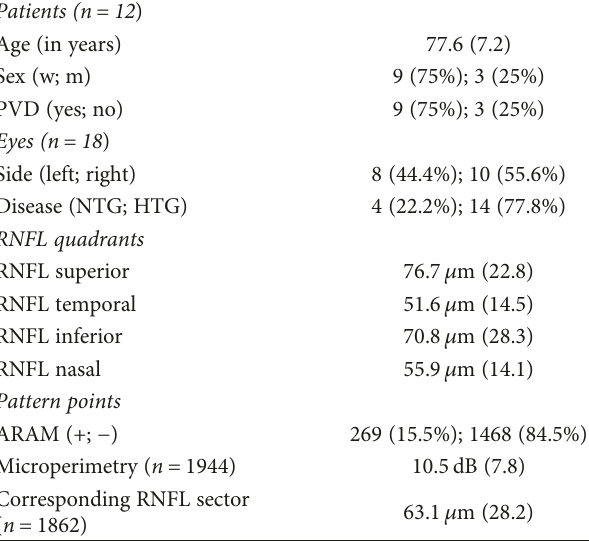
Table 2: Descriptive data of visual fi eld pattern: ARAM+, ARAM − , and mean microperimetry